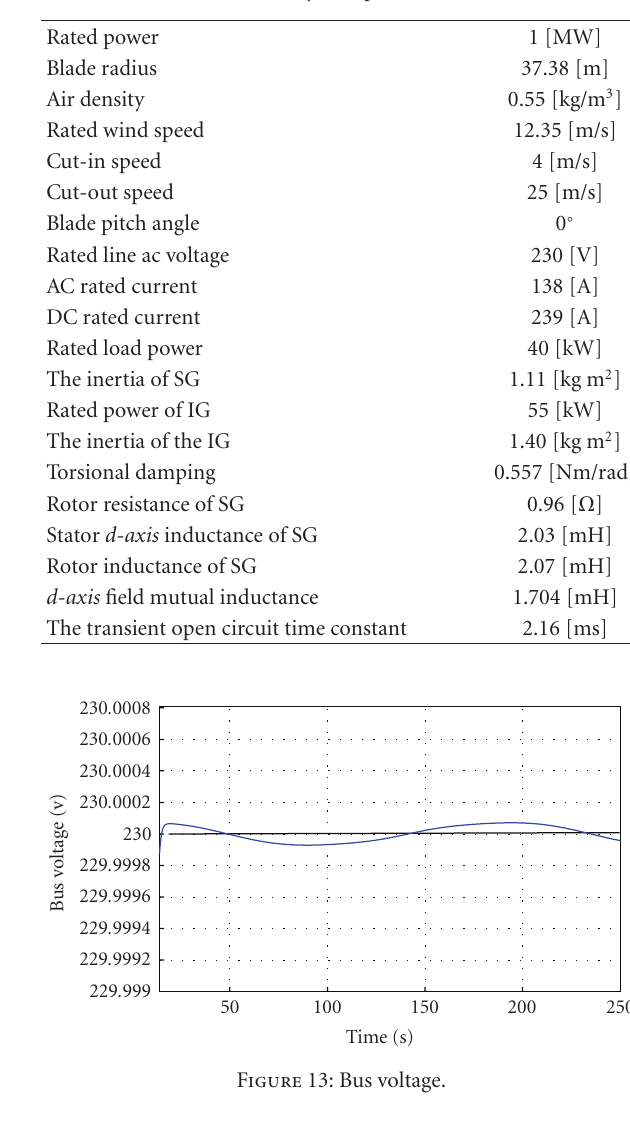
Table 1: System parameters.